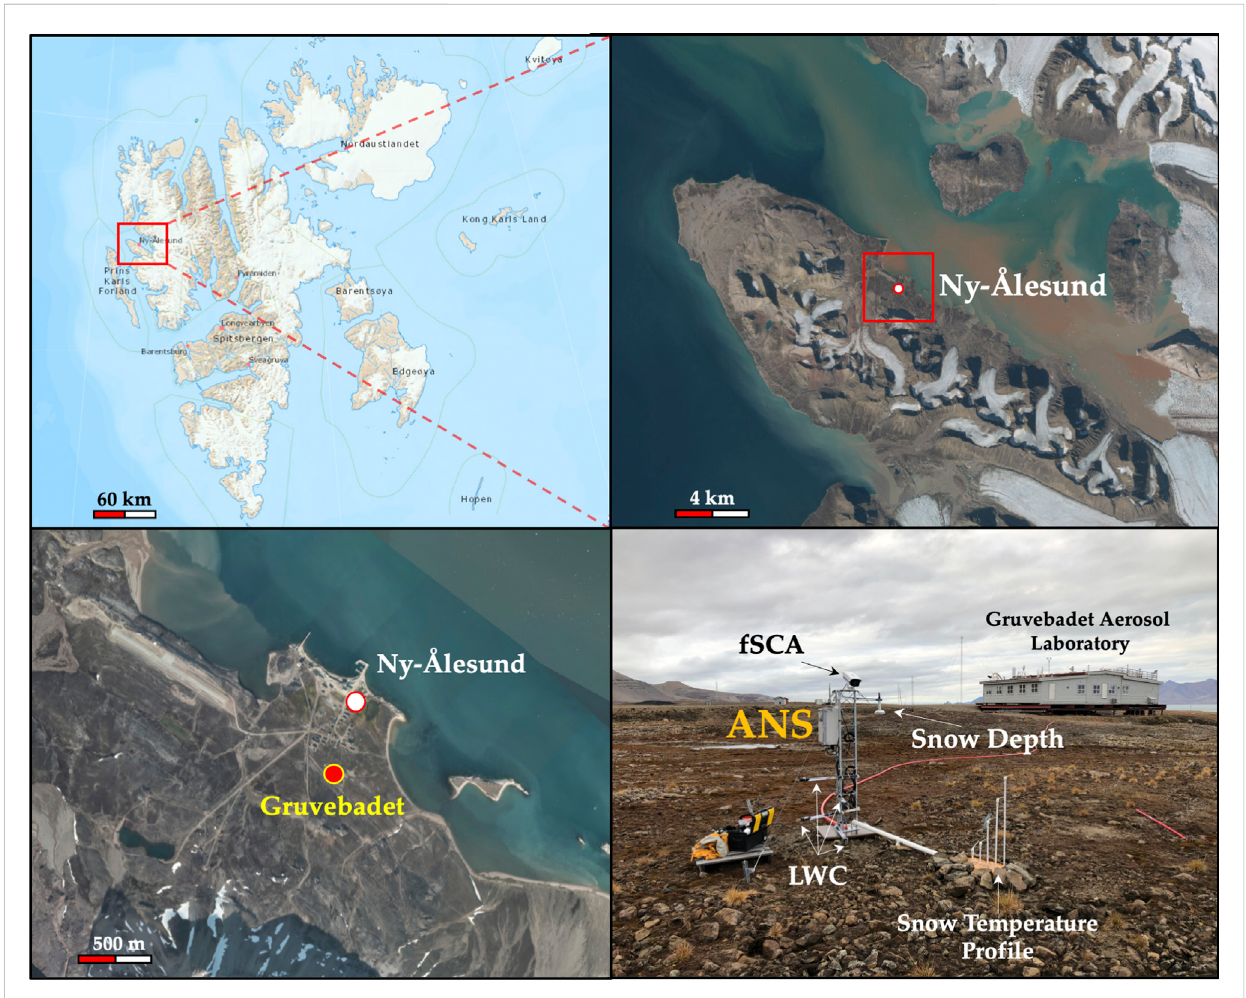
Location and general view of the instrumental set-up composing the Automated Nivometric Station (ANS) installed in Ny-Ålesund (Svalbard) in November 2020. Maps and satellite images from TopoSvalbard